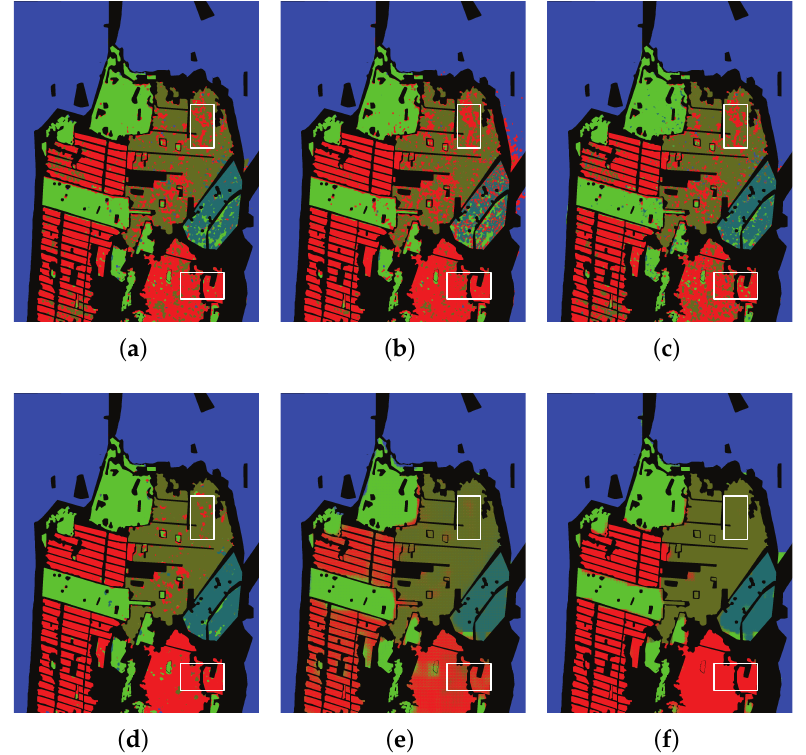
Figure 9. Classification results of San Francisco with various methods. ( a ) SVM. ( b ) SRC. ( c ) SAE. ( d ) CNN. ( e ) SFCN. ( f )